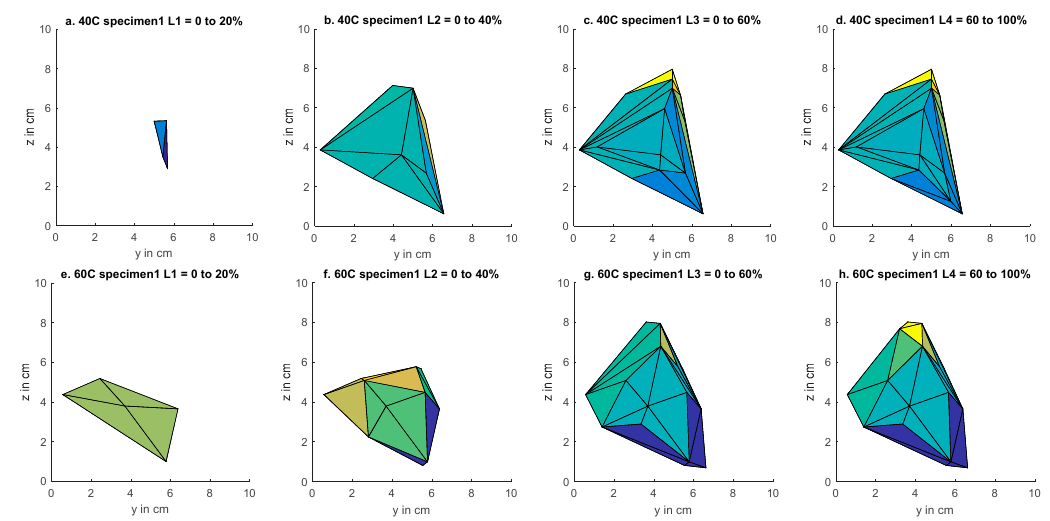
Figure 15. CHV progression seen along the front elevation ( y -and z -axis) for L1, L2, L3, and L4 for specimens WC40C1 ( a – d ), and WC60C1 ( e – h ).